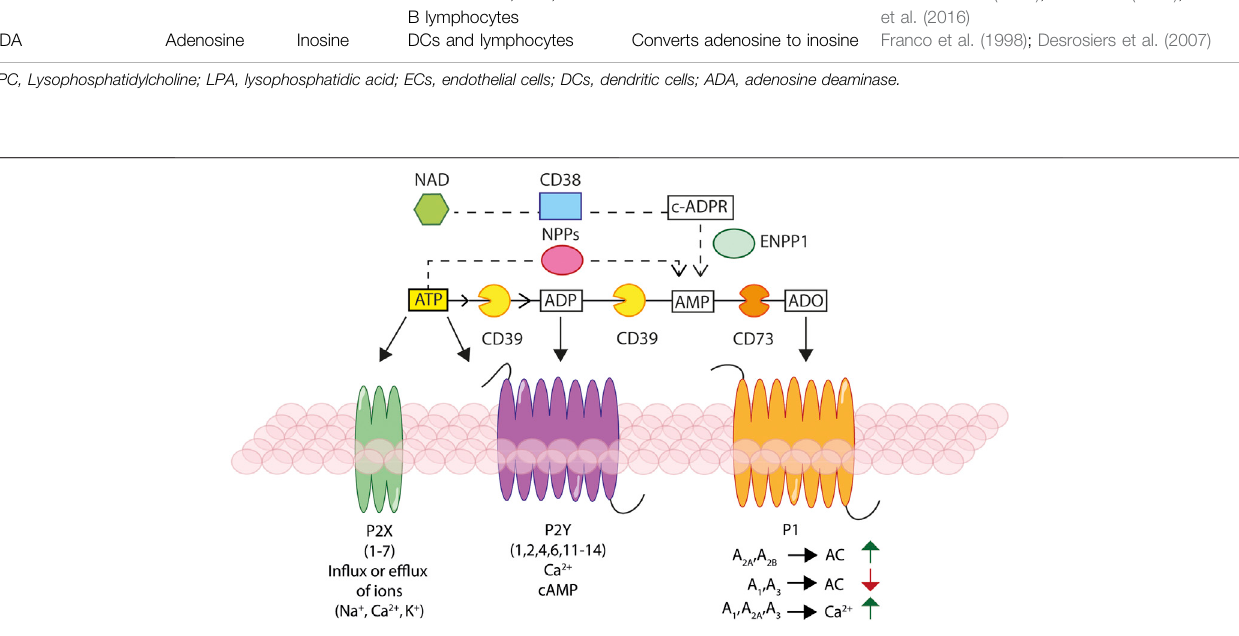
FIGURE 1 | Schematic rendition of the basic elements of the purinergic signalling. Ectonucleotidases, NTPDase1/CD39, NAD glycohydrolase/CD38, NPPs and NT5E/CD73, hydrolyse extracellular ATP and NAD + , generating ADP, AMP, and adenosine (ADO). Extracellular ATP and ADP activate different P2X ionotropic and/or P2Ymetabotropicreceptors,leadingtochangesintheintracellularionand/orcAMPconcentration.ExtracellularADOstimulatesP1receptorsresponsibleofmodulation of adenylate cyclase (AC) activity and leading to changes in cAMP and Ca 2+